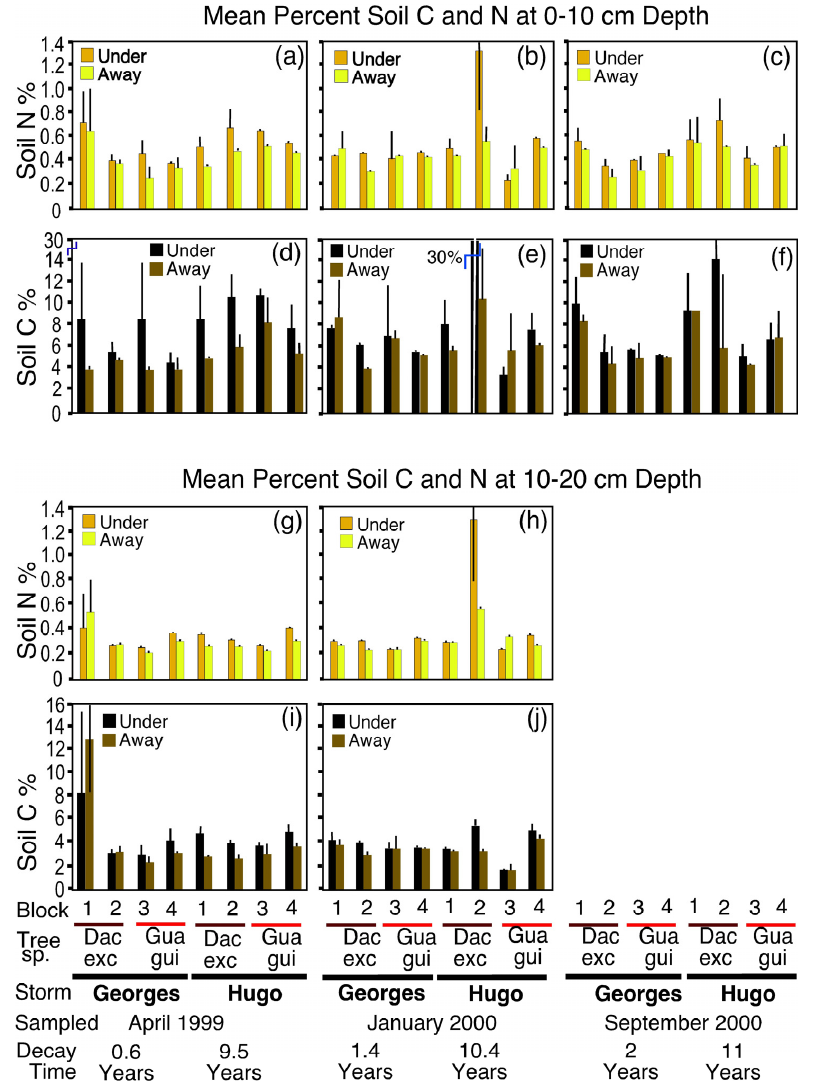
Figure 3. Mean percent soil C and N are presented for paired samples taken under decomposing logs (darker bars) versus samples taken 20–50 cm away and not under the logs (lighter bars) 0.6–2 and 9.5–11 years after Hurricanes Georges and Hugo, respectively. Tree species abbreviations are: Dac exc— Dacryodes excelsa , and Gua gui— Guarea guidonia . Data are means of two samples, one taken in the upslope direction and the other taken in the downslope direction on the same day (SD bars in black). April 1999 sampling was during the dry season, January 2000 was the end of the wet season, and September 2000 was during the wet season. ( a – c ) Mean soil % N at 0–10 cm depth; ( d – f ) Mean soil % C at 0–10 cm depth; ( g , h ) Mean soil % N at 10–20 cm depth; ( i , j ) Mean soil % C at 10–20 cm depth.